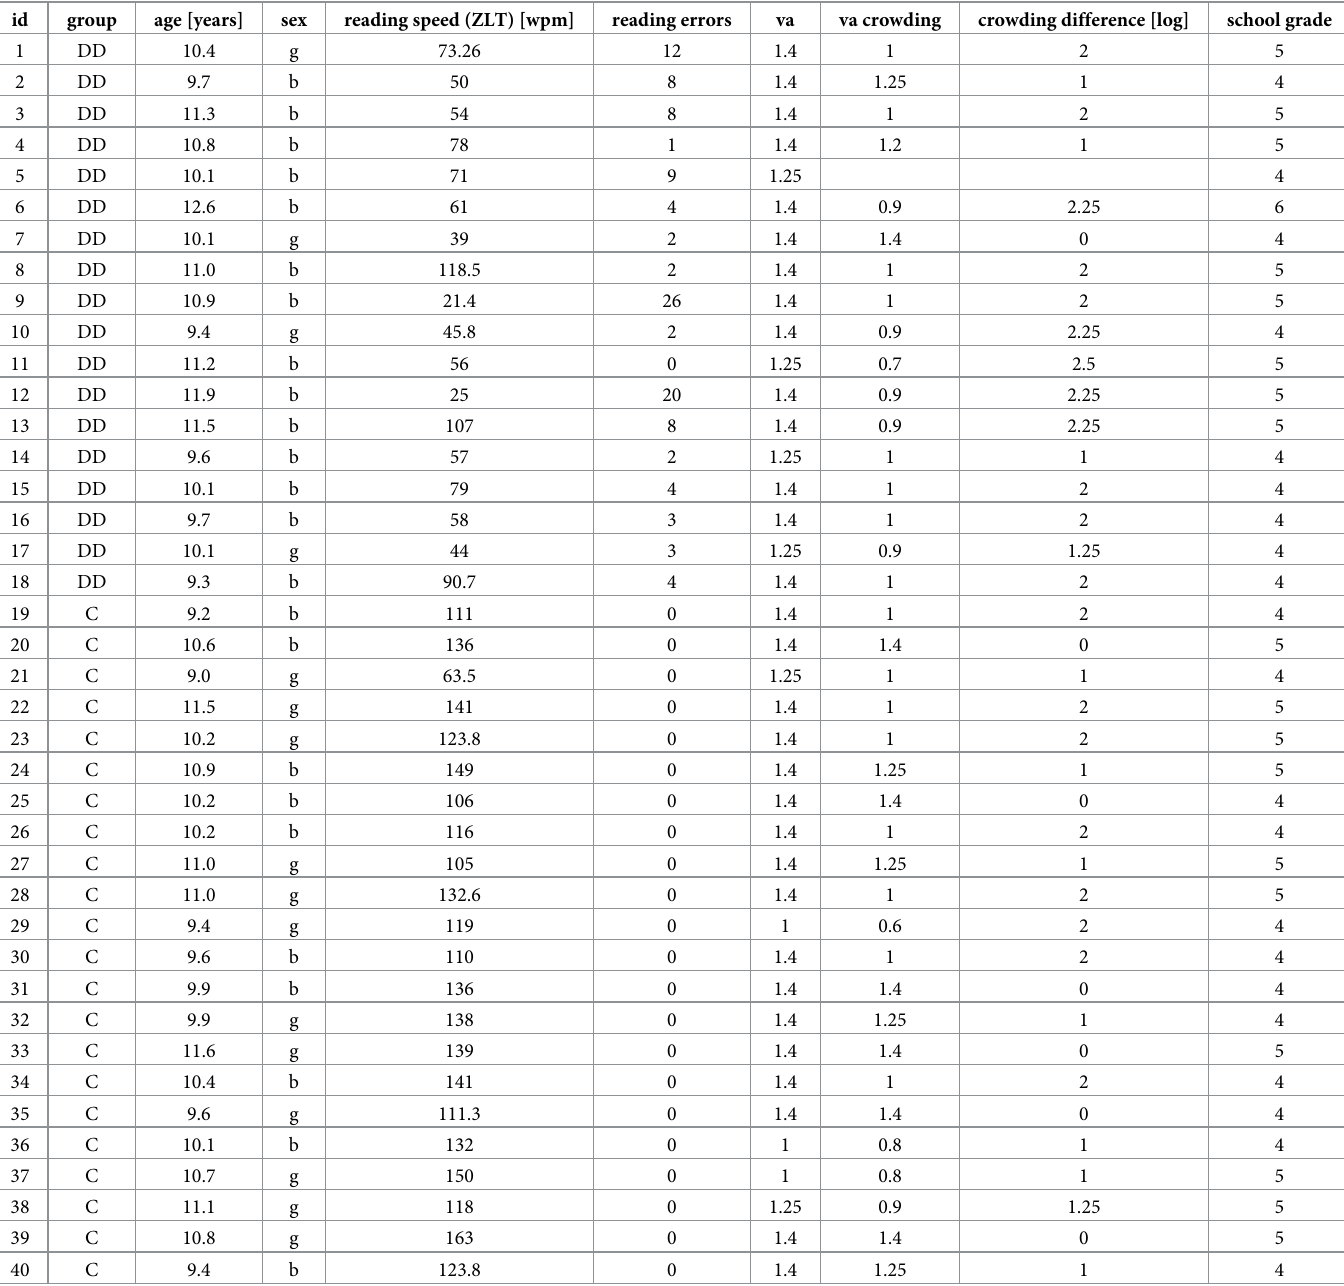
Table 1. Data at